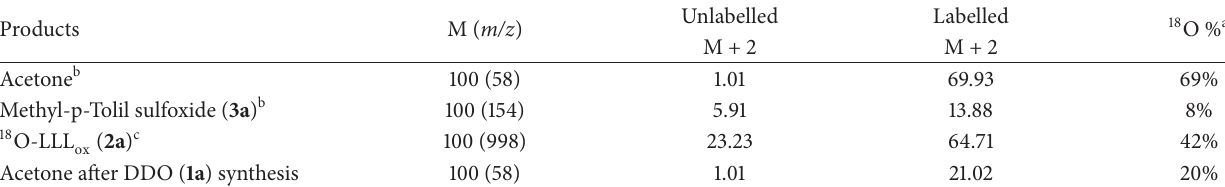
Table 1: Mass spectrometry